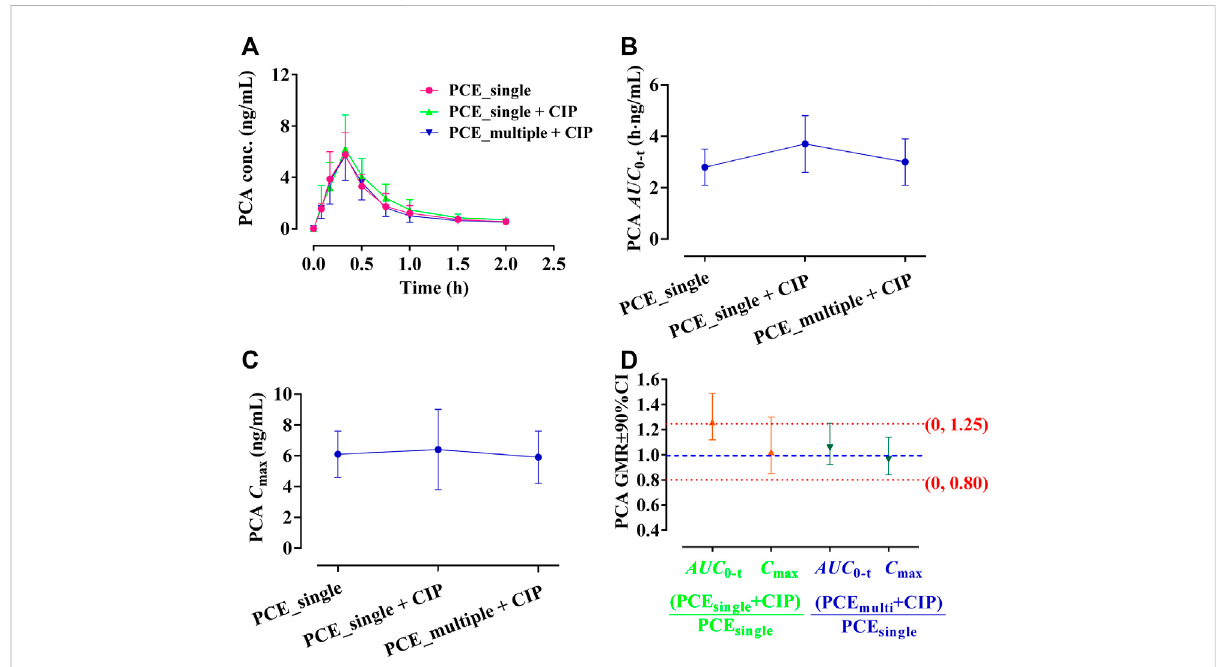
FIGURE 4 Plasmaprotocatechuic acid(PCA)concentration-timepro fi les (A) ,thesystemicexposure parameters ofPCAincluding AUC 0-t (B) and C max (C) , and their 90% CIs for the geometric mean ratios [GMR, (D) ] in the presence and absence of oral cipro fl oxacin hydrochloride tablets (CIP) to healthy humans (mean ± SD, n = 12).